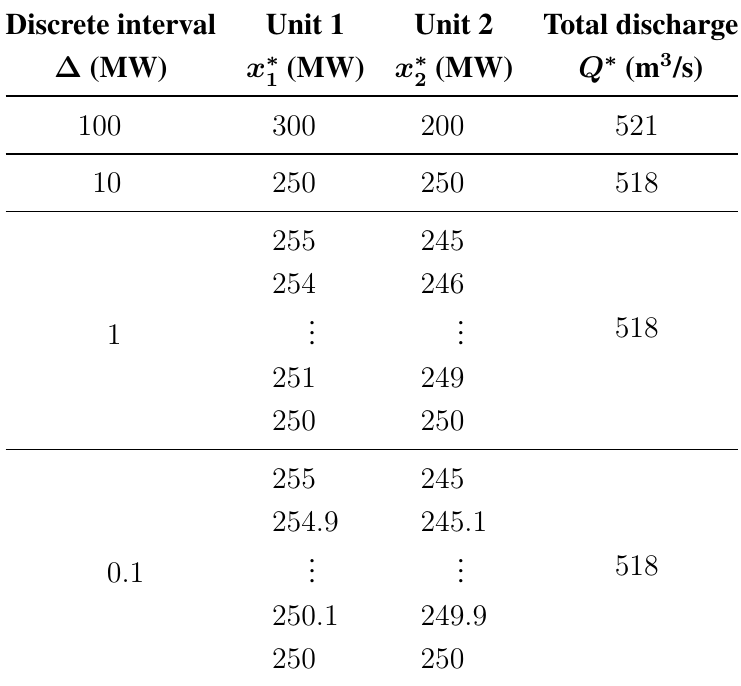
Table 2. The relationship between discrete the interval and solutions in load of 500